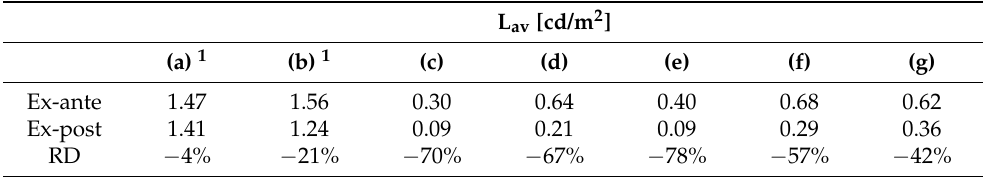
Table 17. Observation point E2: (a) Cassero tower, (b) Belvedere tower, (c) residential building, (d)